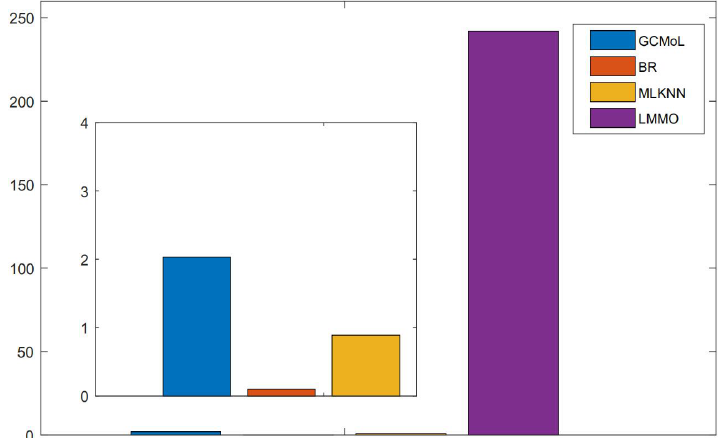
Figure 3. Running time results of different methods on the CAL500